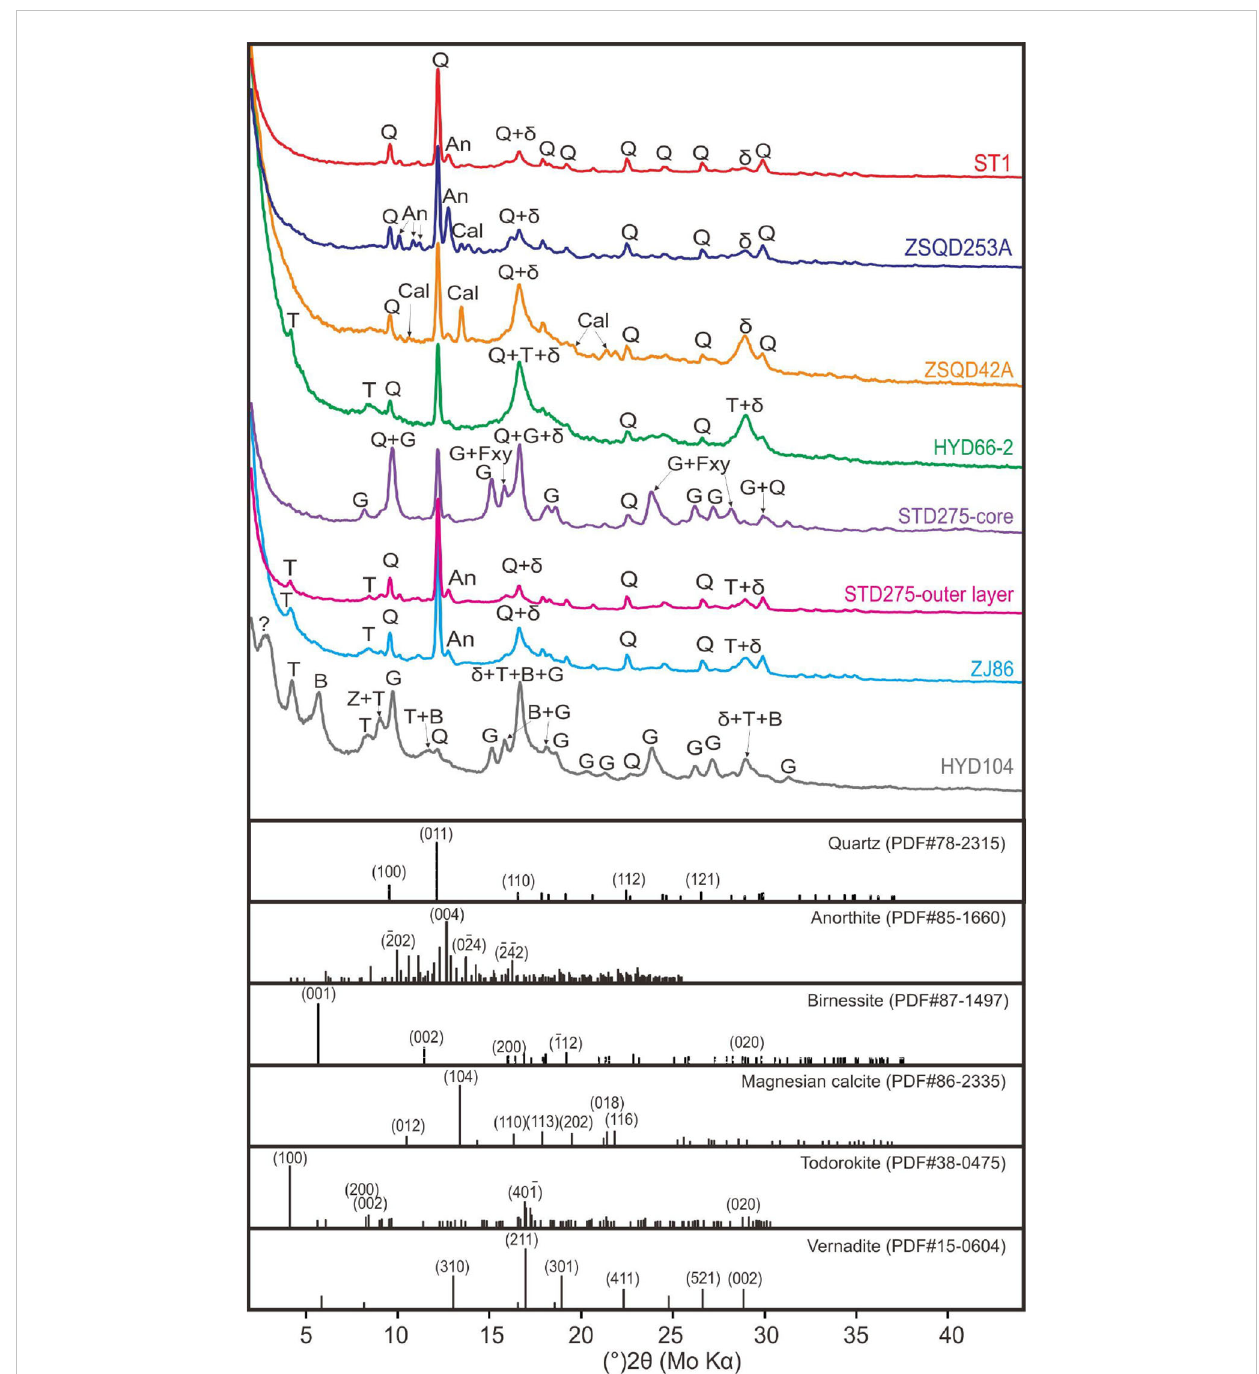
FIGURE 5 XRD patterns of the SCS polymetallic crusts and nodules (Q, quartz; An, Anorthite; Cal, calcite; T, todorokite; G, goethite; B, birnessite; Z, Chloro